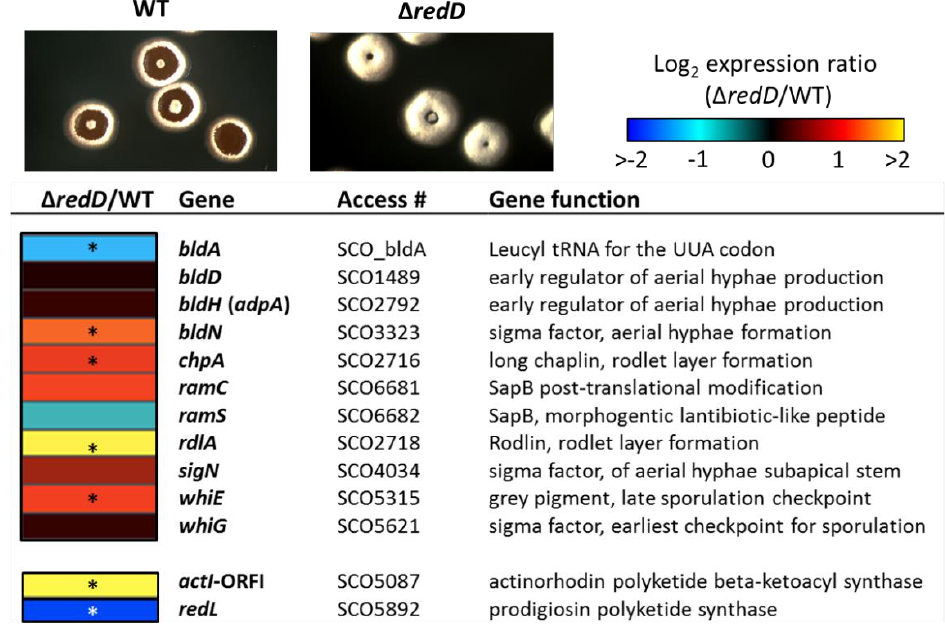
Figure 5. Transcription of developmental genes in S. coelicolor wild-type (M145) and its ∆ redD mutant (M510). Gene names are shown at right of heat map; color legend for Log 2 expression (fold change) is shown above. Genes were considered significantly regulated if they had p values ≤ 0.02 in Student’s T-test (three replicates) when compared between wild-type and mutant strains. Genes meeting this criterion are noted with an asterisk (*). Colonies of S. coelicolor M145 (WT) and M510 ( ∆ redD ) were around 5 mm in diameter.